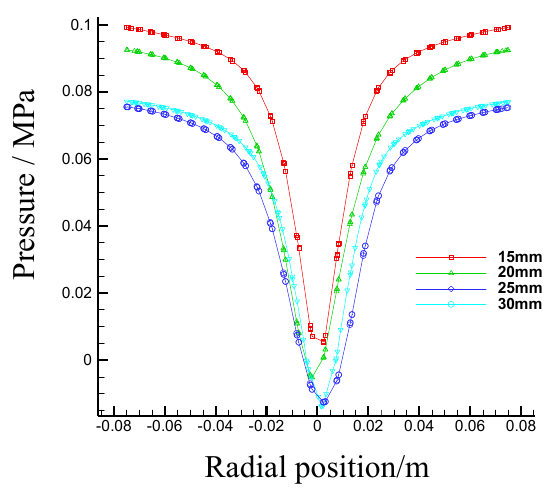
Figure 11. Pressure distribution of hydrocyclone with different inner vortex finder. As shown in Figure 12, four curves correspond to tangential velocities of flow fields in the first section hydrocyclone at internal overflow pipe diameters of 15 mm, 20 mm, 25 mm, and 30 mm respectively. The tangential velocities increase along with the overflow outlet diameter increase. In addition, the location of the maximum tangential velocity shifted outwards along the radial direction as the internal overflow pipe diameter increased. This can be attributed to the outward shift of trajectory surface of maximum tangential velocity as a result of increase of the overflow pipe diameter.